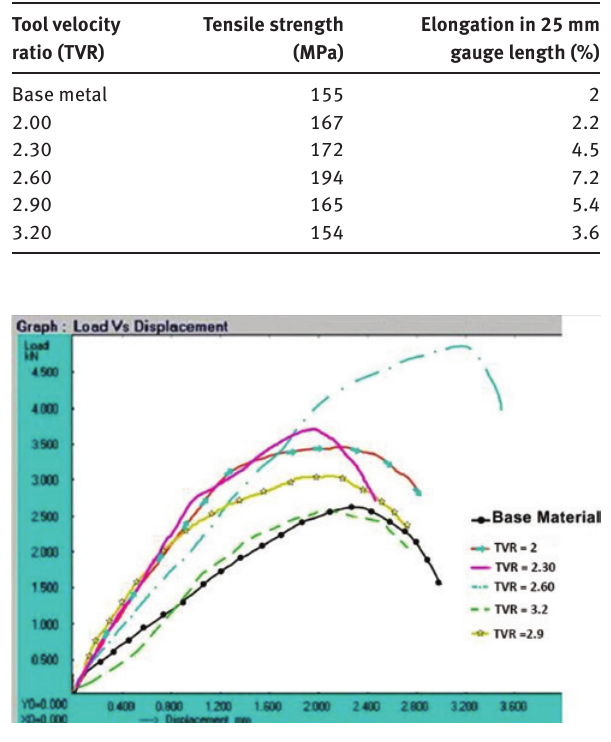
Figure 5: Load displacement